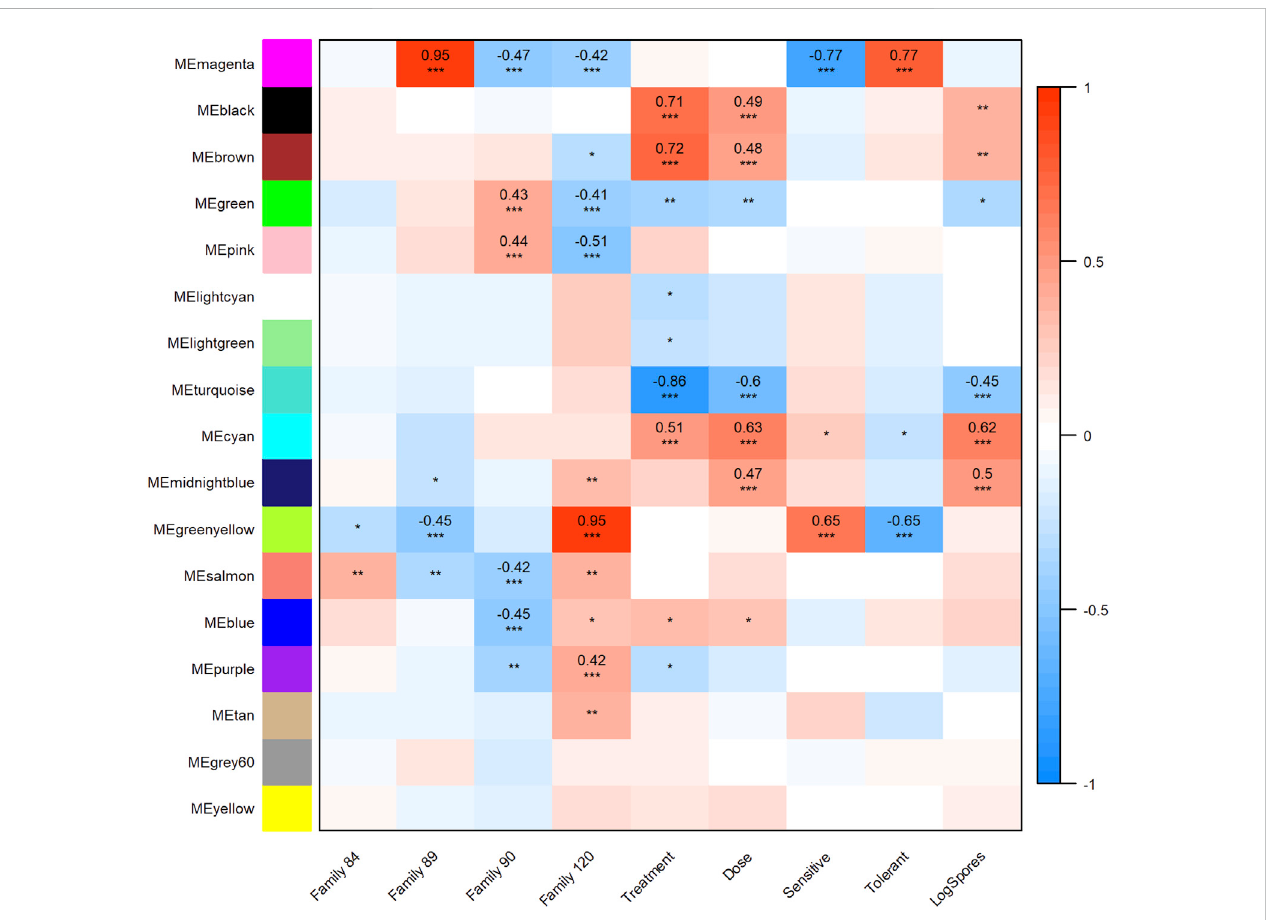
Weighted Gene Correlation Network Analysis module-trait relationship heat map. Trait (columns) to eigengene (row) correlation p -values ≤ 0.001 are represented as “ ***, ” p -values ≤ 0.01 and > 0.001 as “ **, ” and p -values ≤ 0.05 and > 0.01 as “ * ” . The color scale shows the strength of each correlation, ranging from dark blue ( − 1) to dark red (1), correlation values are shown for module trait relationships that were highly signi fi